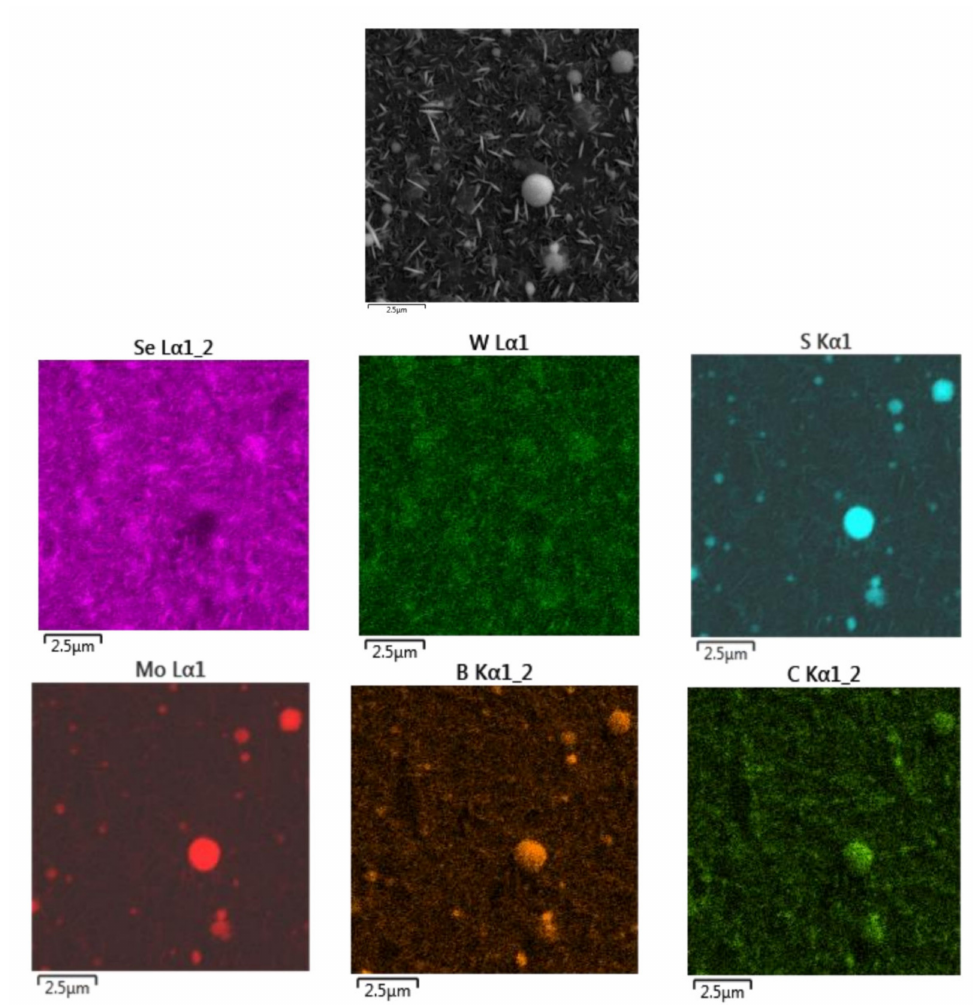
Figure 9. SEM image (top gray) and EDS maps (colored) of element distribution on the surface of the MoS x /WSe 2 /C(B)/Al 2 O 3 sample. Intensity of different colors indicates where the corresponding elements (Se, W, S, Mo, B, and C) are most abundant. The presence of submicron rounded particles is explained by B-rich particle deposition during C(B) film